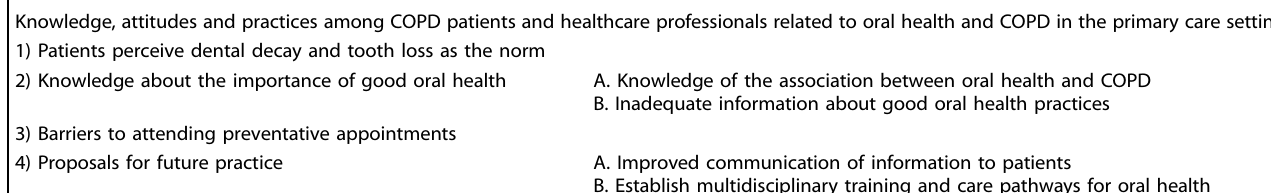
Table 3. Themes and subthemes. Knowledge, attitudes and practices among COPD patients and healthcare professionals related to oral health and COPD in the primary care setting 1) Patients perceive dental decay and tooth loss as the